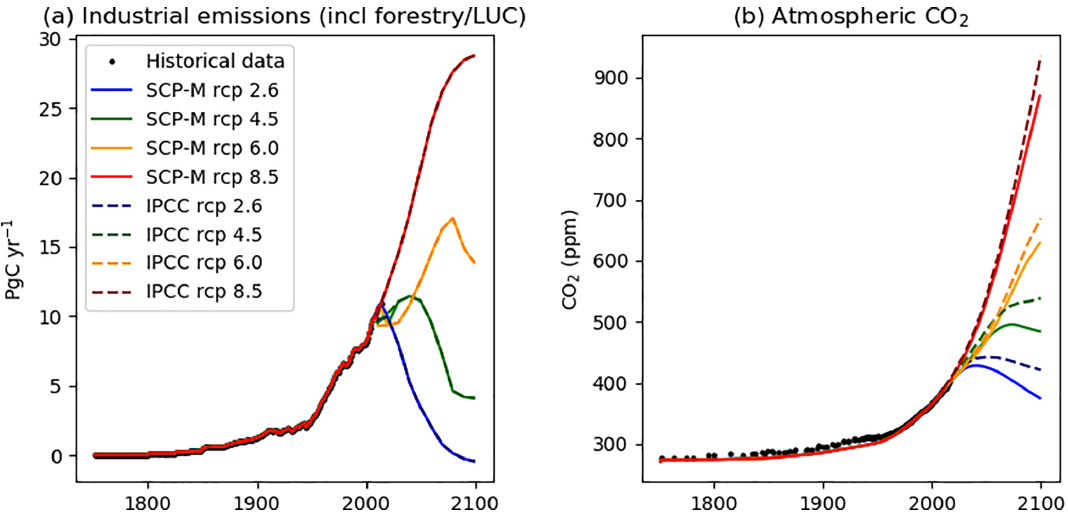
Figure 6. SCP-M RCP modelling results compared with IPCC emissions and CO 2 scenarios. Panel (a) shows the IPCC’s RCP emissions pathways out to 2100, which are inputted to SCP-M for the modern carbon cycle simulation. Panel (b) shows SCP-M model output for atmospheric CO 2 (firm lines) plotted against IPCC atmospheric CO 2 projections for the RCP pathways (dashed lines). The SCP-M output undershoots the IPCC projections for RCP2.6 and 4.5, but provides a close match with RCP6.0 and